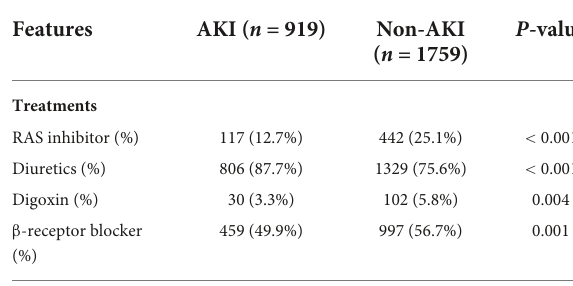
TABLE 1 Clinical characteristics of HF